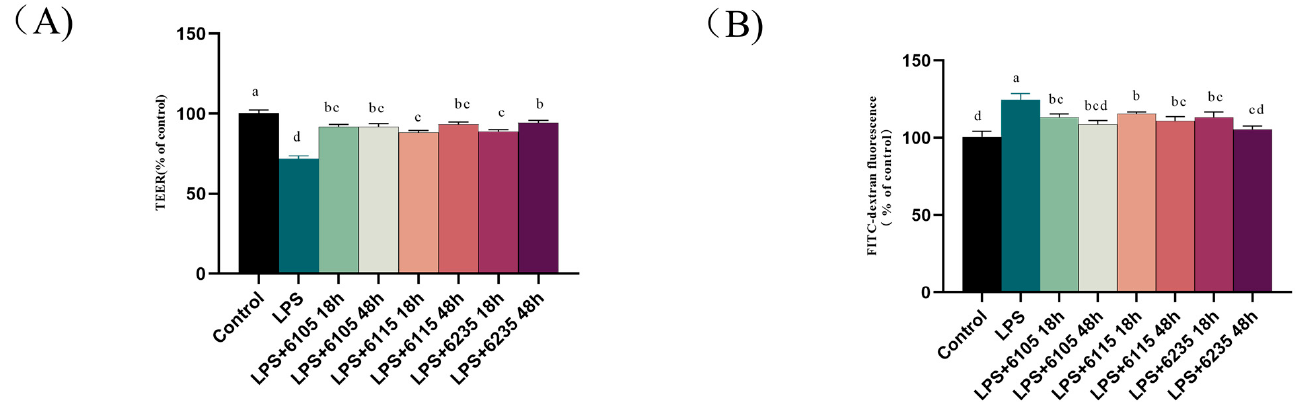
Figure 2. Effect of heat-killed L. paracasei (HK-LP) 6105, 6115, and 6235 (1 µ g/mL) at different cultivation times (18 h or 48 h) on transepithelial electrical resistance (TEER) ( A )and fluorescein isothiocyanate (FITC)-dextran fluorescence values ( B ) in lipopolysaccharide (LPS) (100 µ g/mL)- treated Caco-2 cell monolayers after 24 h. HK-LP 6105, 6115, and 6235 were incubated for 18 h and 48 h, respectively; after that, they were heat-killed for 30 min at 100 ◦ C. Control: untreated control cells; LPS: LPS-treated cells. Each result is represented as the mean ± standard error of the mean (SEM) from three independent experiments. Different lowercase letters (a, b, c, d) indicate different levels of significance ( p < 0.05) and the same letters represent no significant difference ( p > 0.05).